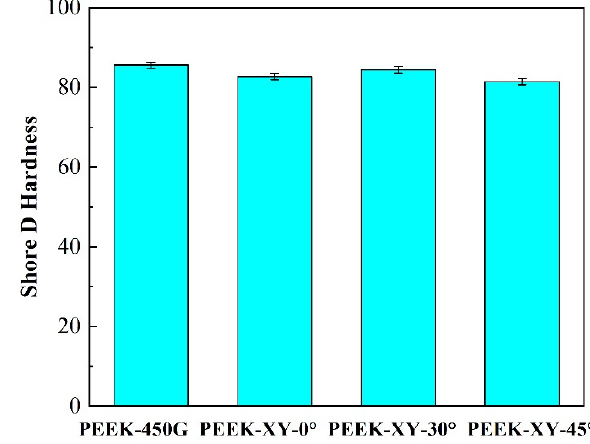
Figure 5. Surface hardness of PEEK 450G and FDM fabricated PEEK parts.